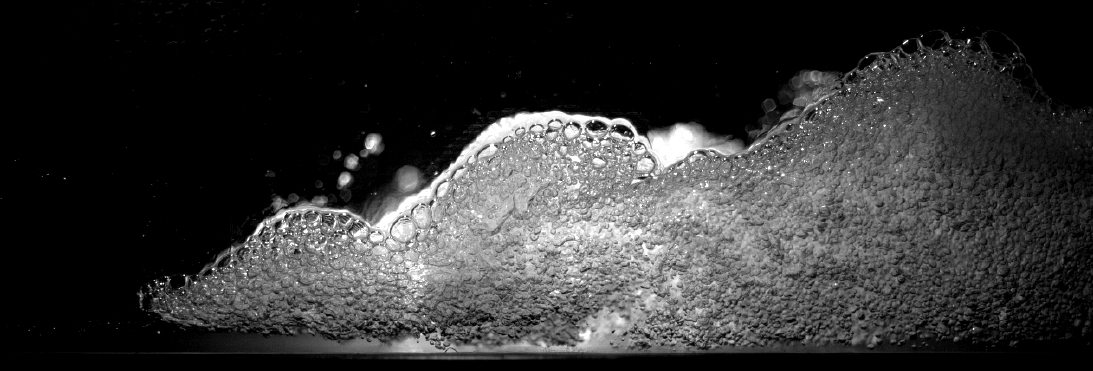
Figure 1. Hydraulic jump at the Hydraulics Laboratory of The University of Queensland (inlet Froude number 7.5, flow from left to right). Courtesy of Dr.